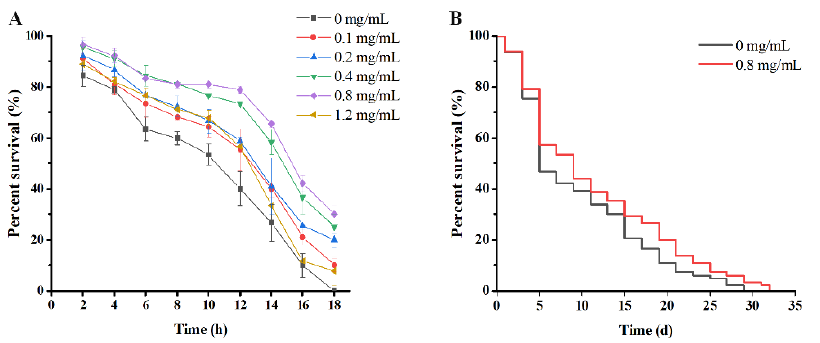
Figure 4. Effect of PE fruit polyphenols on the thermal resistance ( A ) and lifespan ( B ) in C. elegans . 3.5.3. PE Fruit Polyphenols Inhibited the Cholinesterase Activities in C. elegans